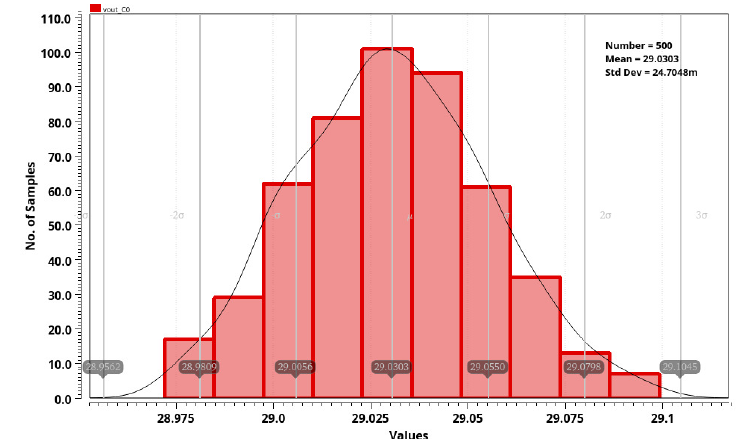
Figure 10. Monte Carlo simulation with A1A2 = 00, VBB = 24